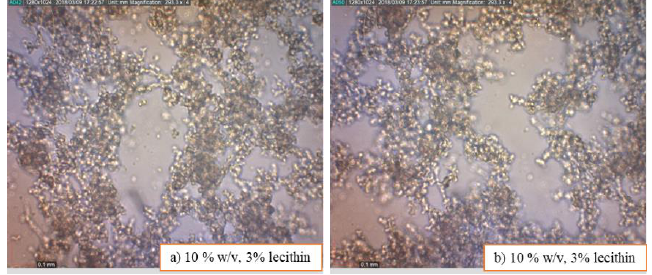
Figure 1. Microscopic image of oil droplets in black seed oil (BSO) emulsion. ( a ) Freshly prepared and ( b ) after centrifugation at 4000 rpm for 5 min. Magnification at 10×. Table 1. Effect of lecithin concentration on particle size, zeta potential and emulsion stability (ES) of alginate-BSO emulsion. Data were presented as mean ± SD ( n = 3). * denotes significant difference after centrifugation ( t -test, p < 0.05).